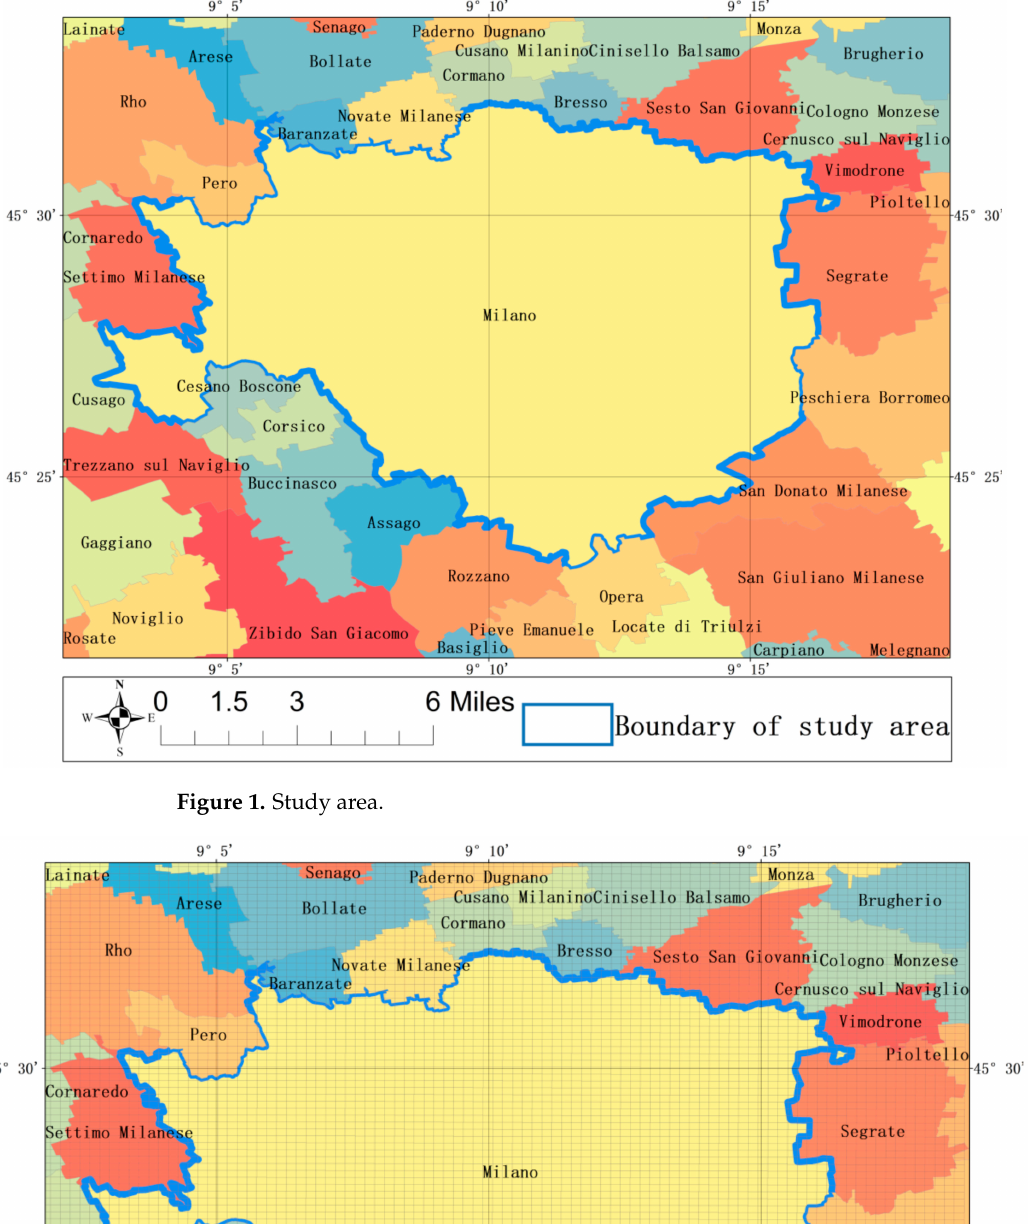
Figure 1. Study area.